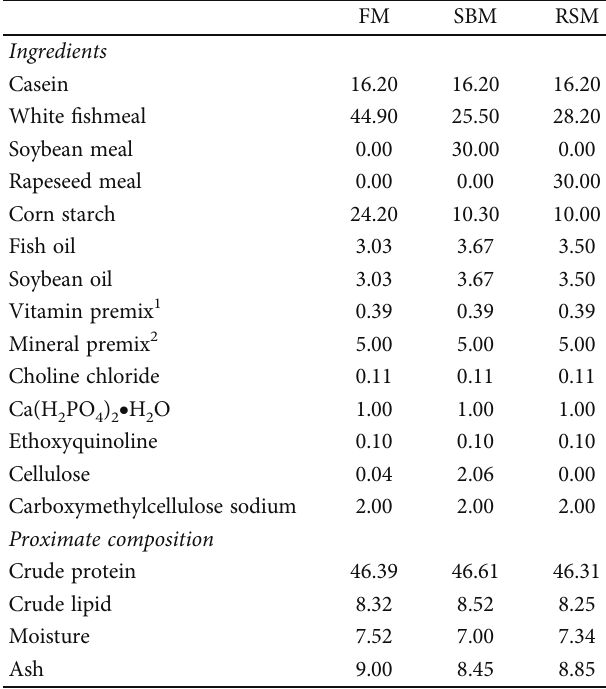
Table 1: Formulation and proximate composition of the experimental diets (% dry